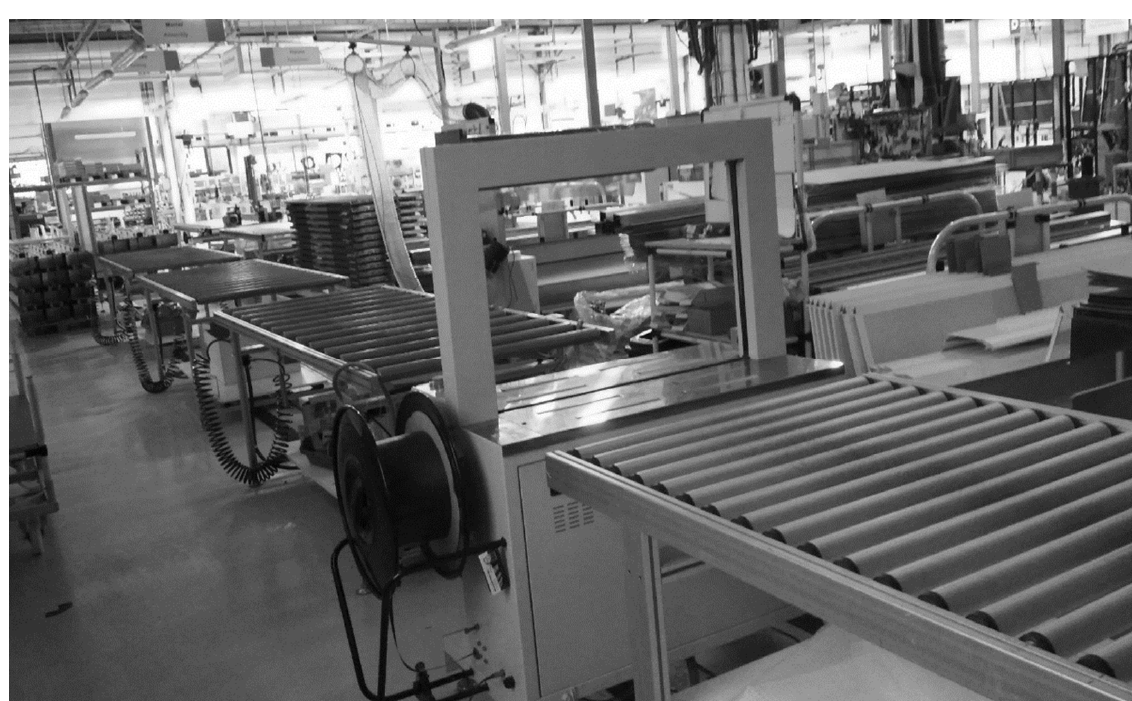
Figure 6. Assembly line.